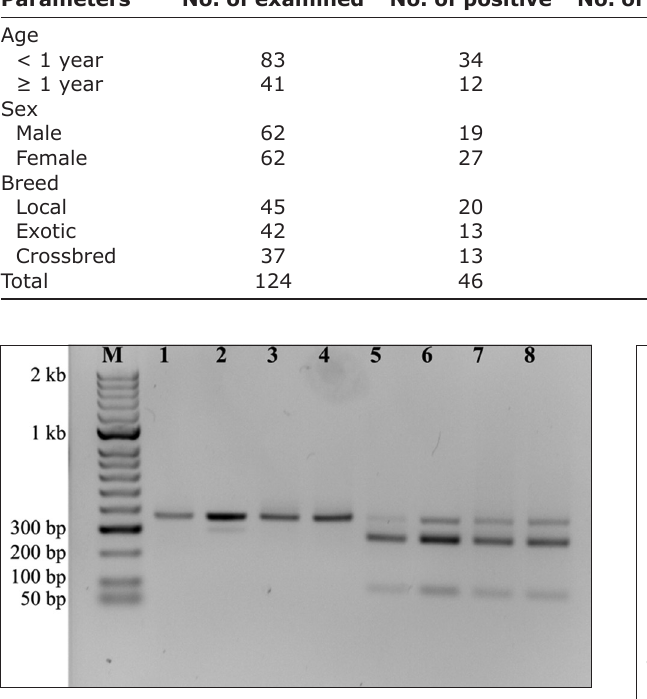
Table-1: Prevalence of Toxoplasma gondii infection in domestic cats from Muang District, Phayao, Thailand. Parameters